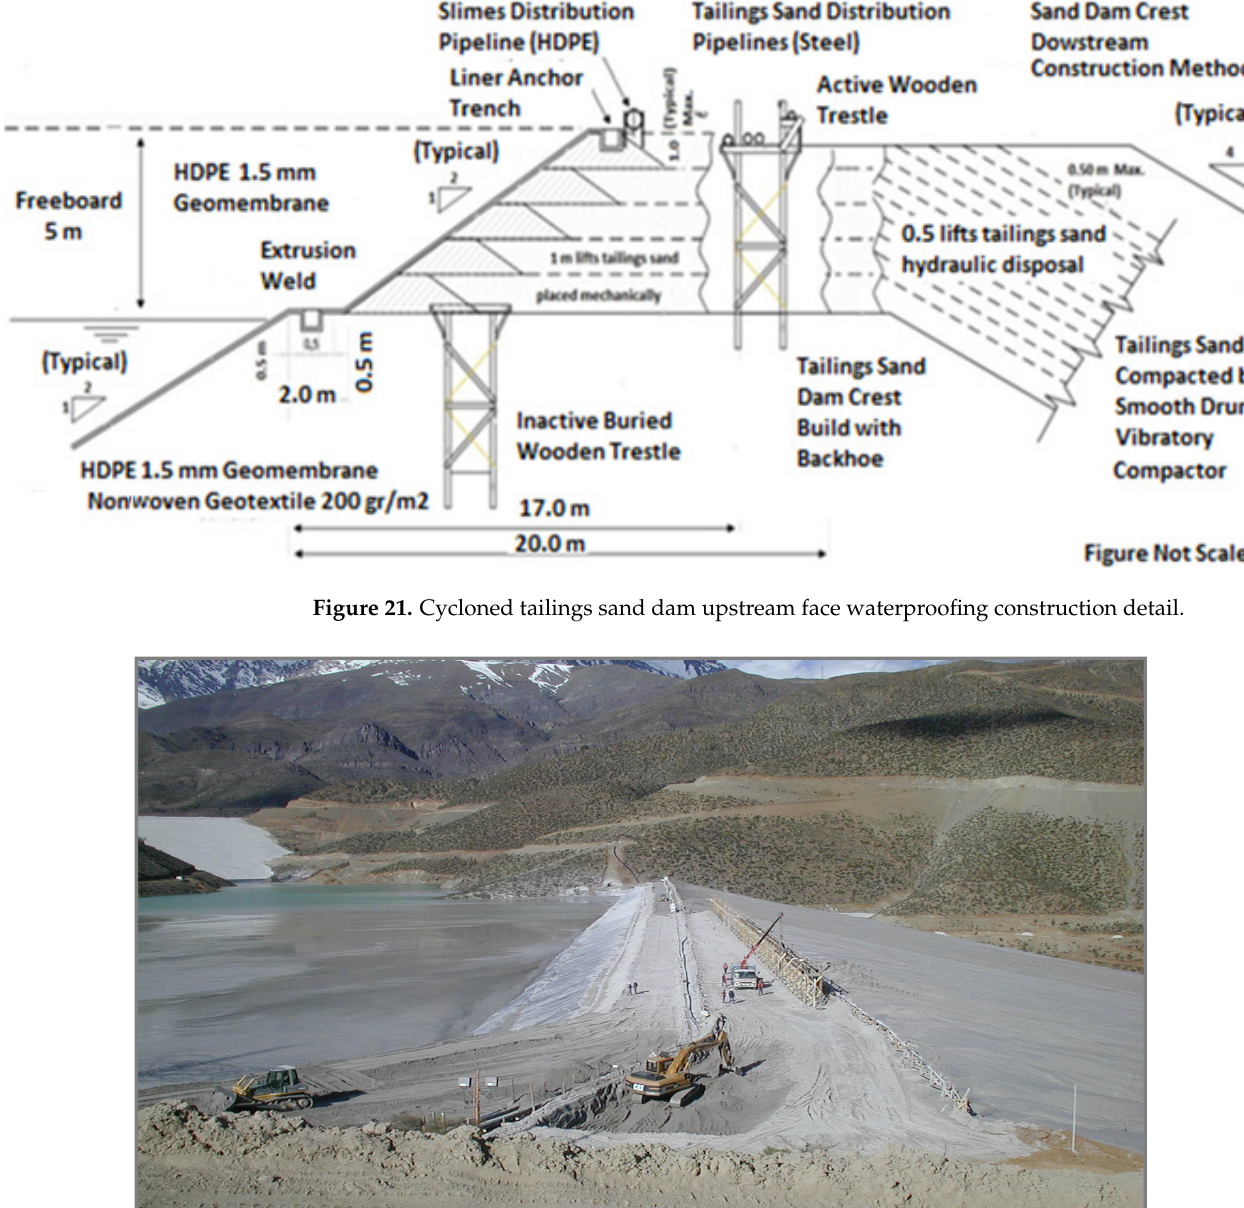
Figure 20. Cycloned tailings sand dam upstream face waterproofing—TSF, Chile [44].